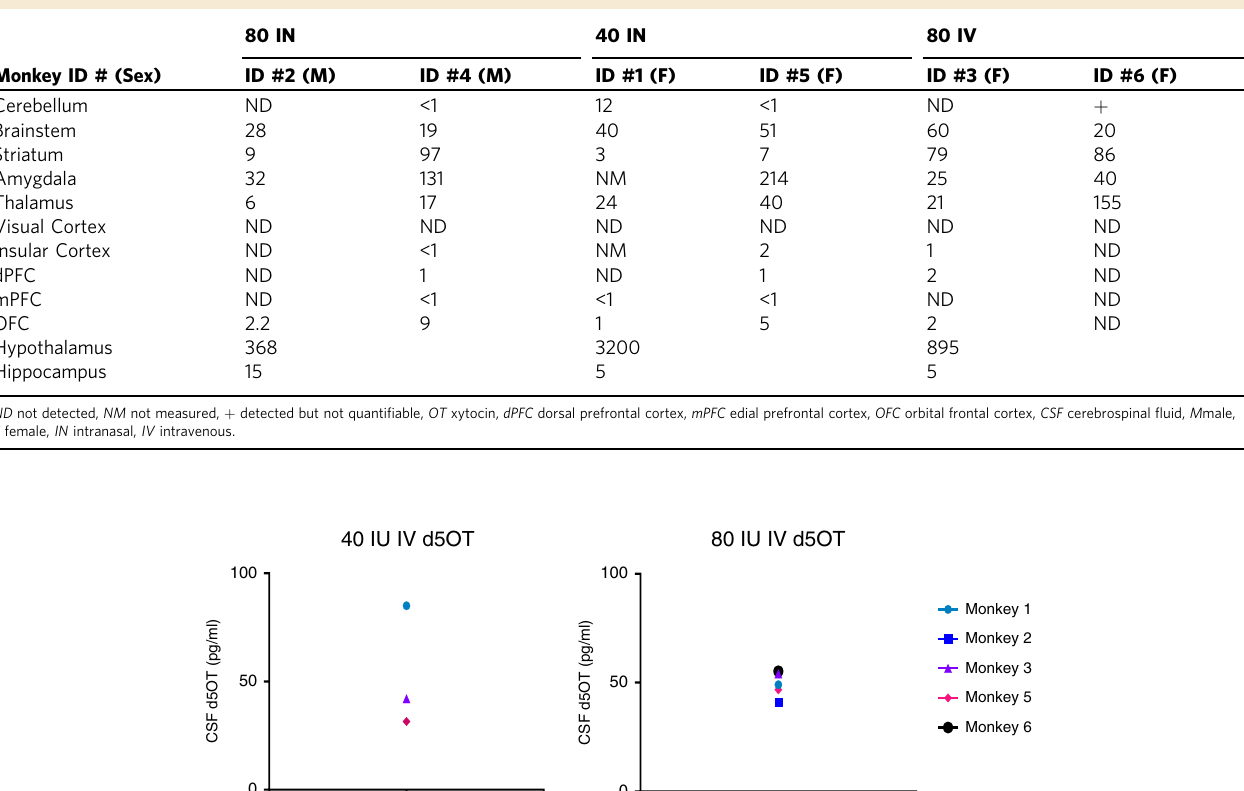
Table 3 Concentrations (nM) of endogenous brain oxytocin